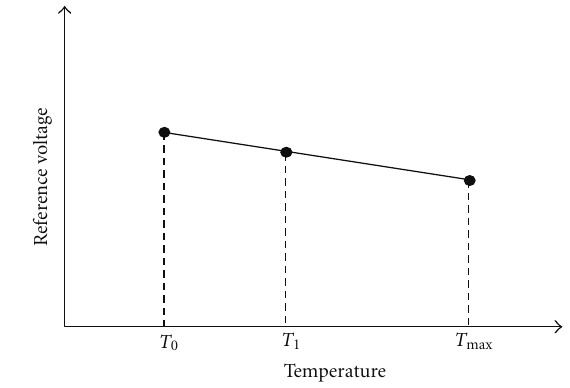
Figure 14: Illustration of the relationship between reference voltage and